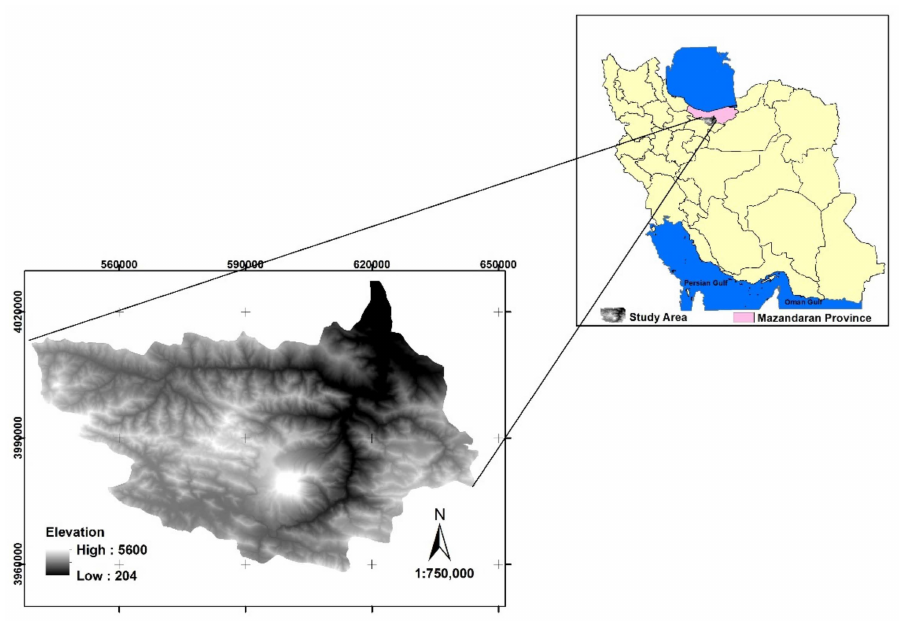
Figure 1. Location and satellite image of the study area in Iran. The lower map is a digital elevation model of the study